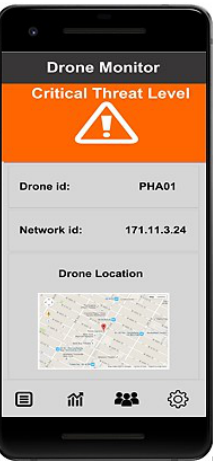
Figure 11. Result